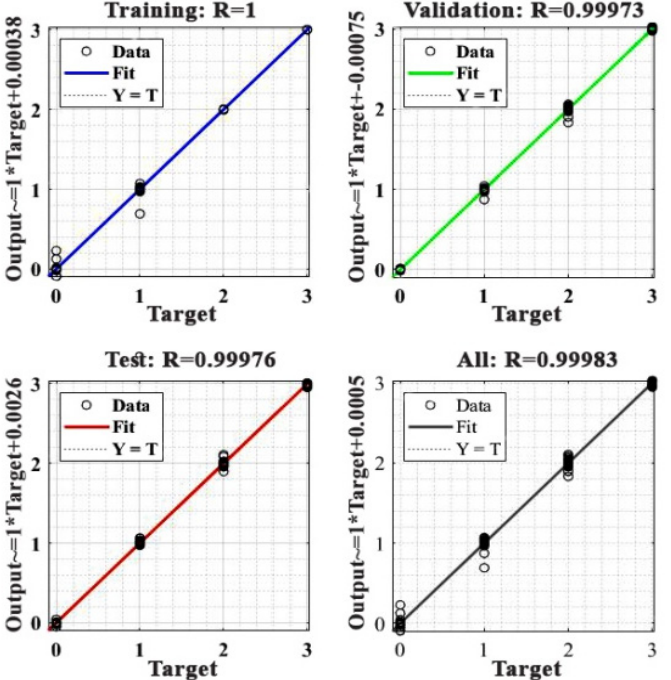
Figure 12. Regression parameter R for CO and CO 2 Analysis Feed Forward Neural Network (FFNN).